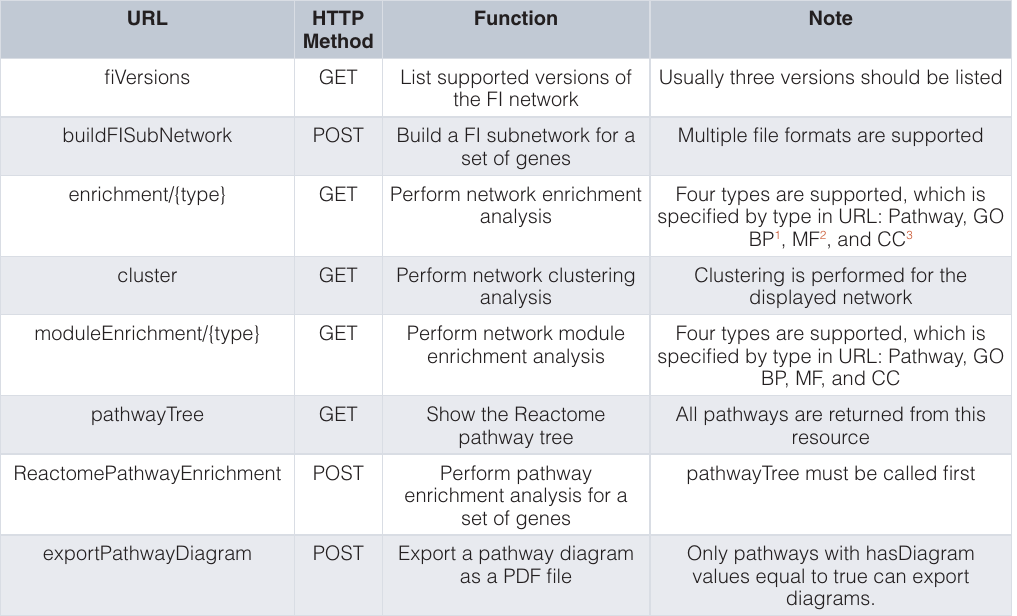
Table 1. List of ReactomeFIViz CyREST API.